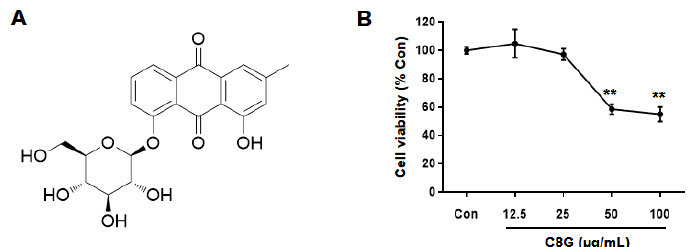
Figure 2. Cytotoxicity of chrysophanol 8- O -glucoside (C8G) in LX-2 cells. ( A ) Structure of C8G. ( B ) Cytotoxicity of C8G in LX-2 cells was assessed by WST-1 assay. LX-2 cells were treated with C8G for 48 h after activation by TGF- β 1 for 48 h. Each experiment was repeated three times, and the values represent mean ± SD. ** p < 0.01 compared with TGF- β 1-treated cells.